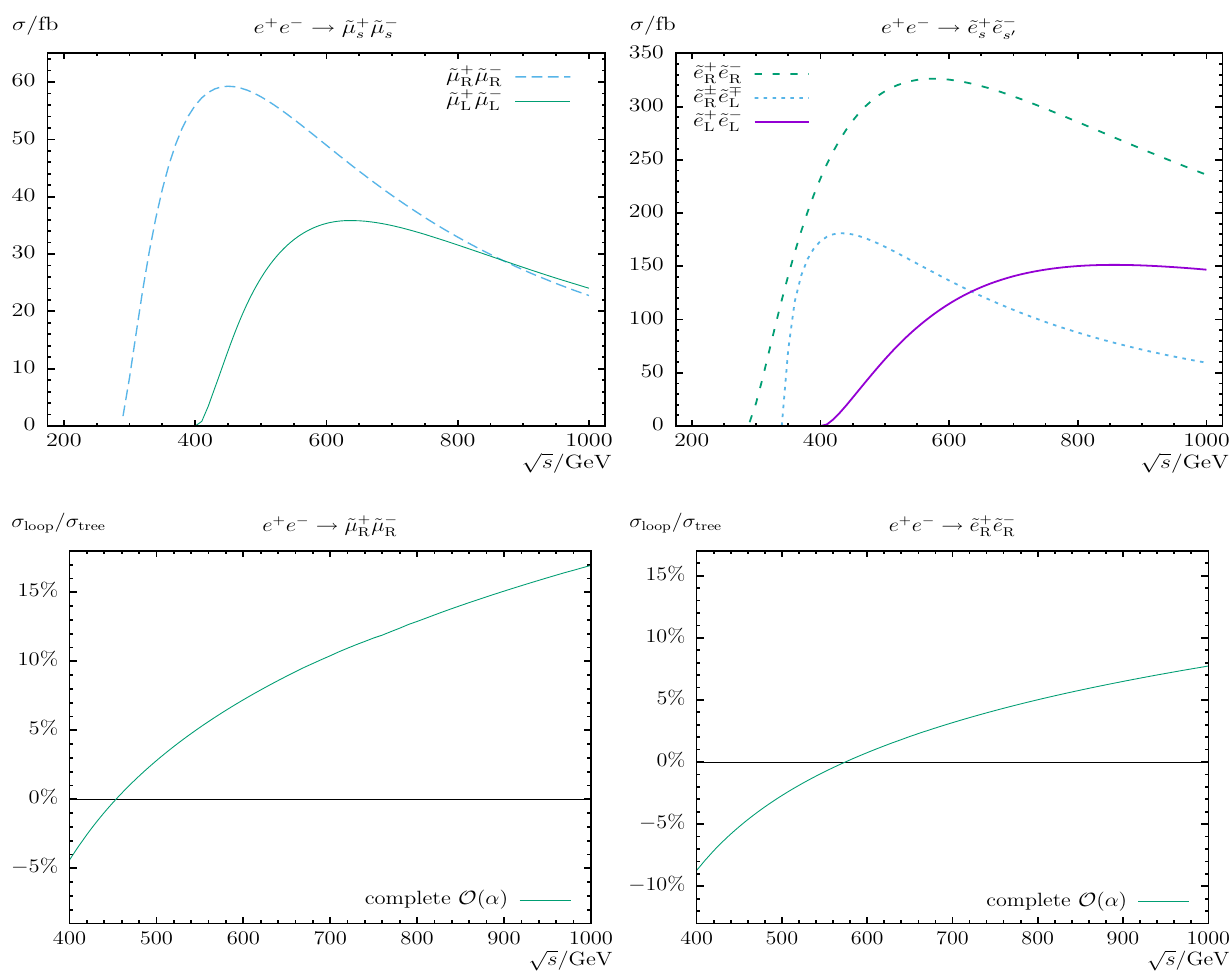
Fig. 4 Comparison with Ref. [39] for e + e − → ˜ e s ˜ e s (cid:3) , ˜ μ s ˜ μ s (cid:3) . Born cross sections (upper row) and complete relative one-loop results (lower row) are shown for the SPS1 a parameter point as given according to Ref. [39] as a function of